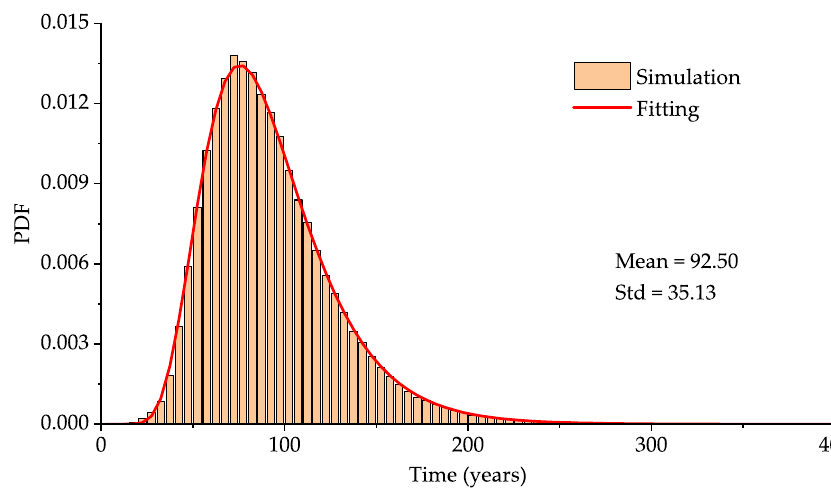
Figure 8. Probability distribution of T ci with µ ( x 0 ) = 50 mm.